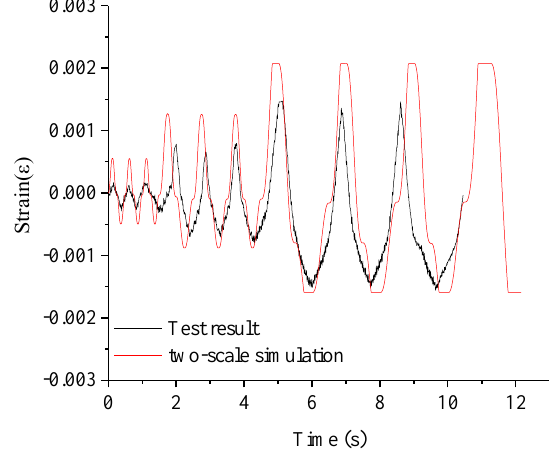
Appl. Sci. 2020 , 10 , x FOR PEER REVIEW Figure 11. Time-history curves of steel strain. Figure 11. Time-history curves of steel strain.